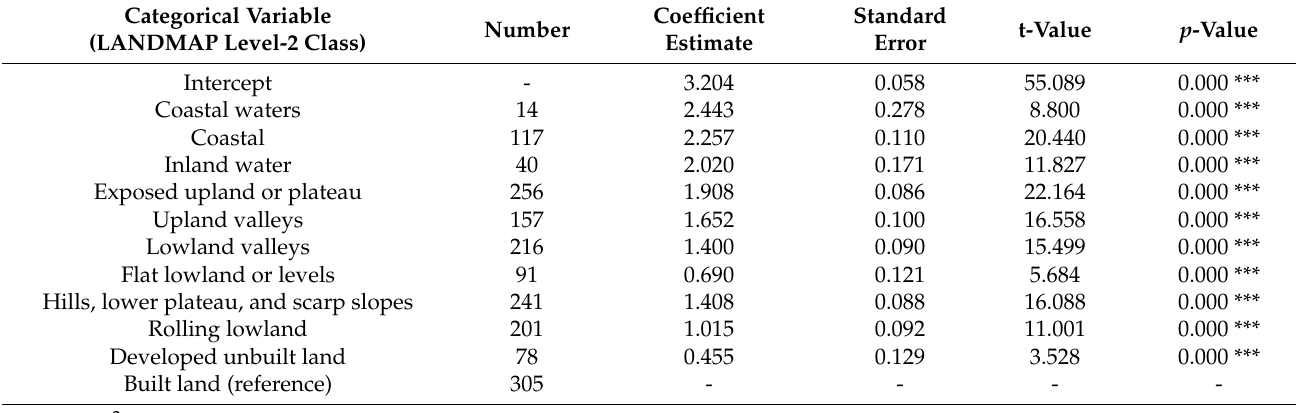
Table 5. Results of the simple linear regression, examining the relationship between the dummy-coded level-2 classes and the “built land” class is used as the reference category and the average scenic ratings that are aggregated over the units of the visual and sensory aspect areas (* p < 0.05, ** p < 0.01, *** p <